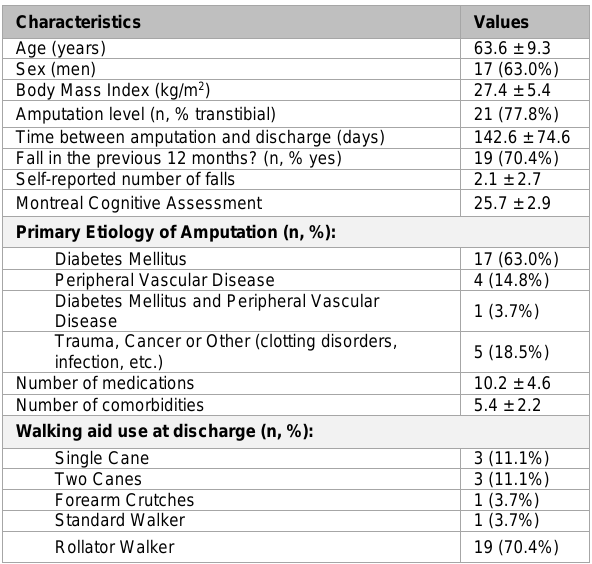
Table 1: Demographic and study characteristics of older adults with first major, unilateral lower limb amputation at discharge from prosthetic rehabilitation. ( n=27 ).